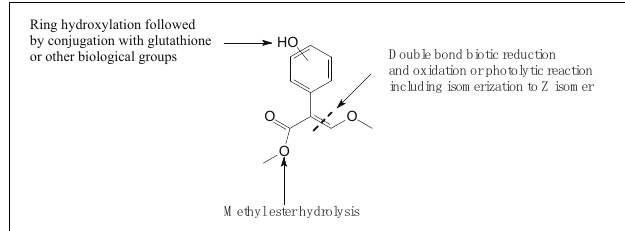
FIGURE 2 | Basic degradation pathways of strobilurins (based on Balba,